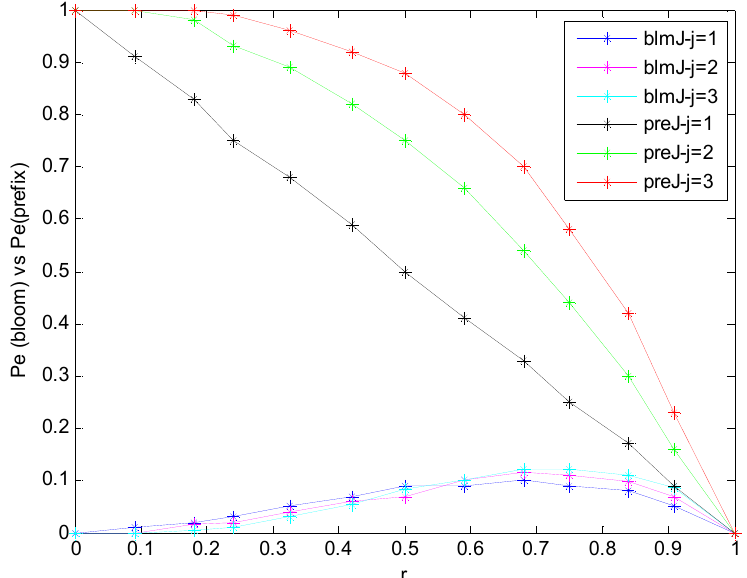
Figure 9. Comparison of error resolution rate between Bloom filter and prefix aggregation.